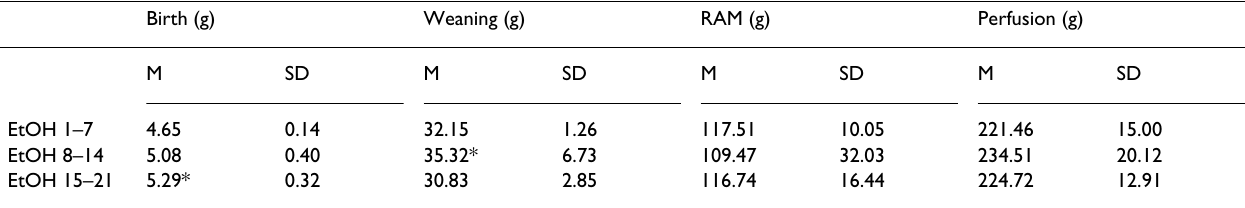
Table 6: Male Weight Data for EtOH weekly treatment groups. Birth